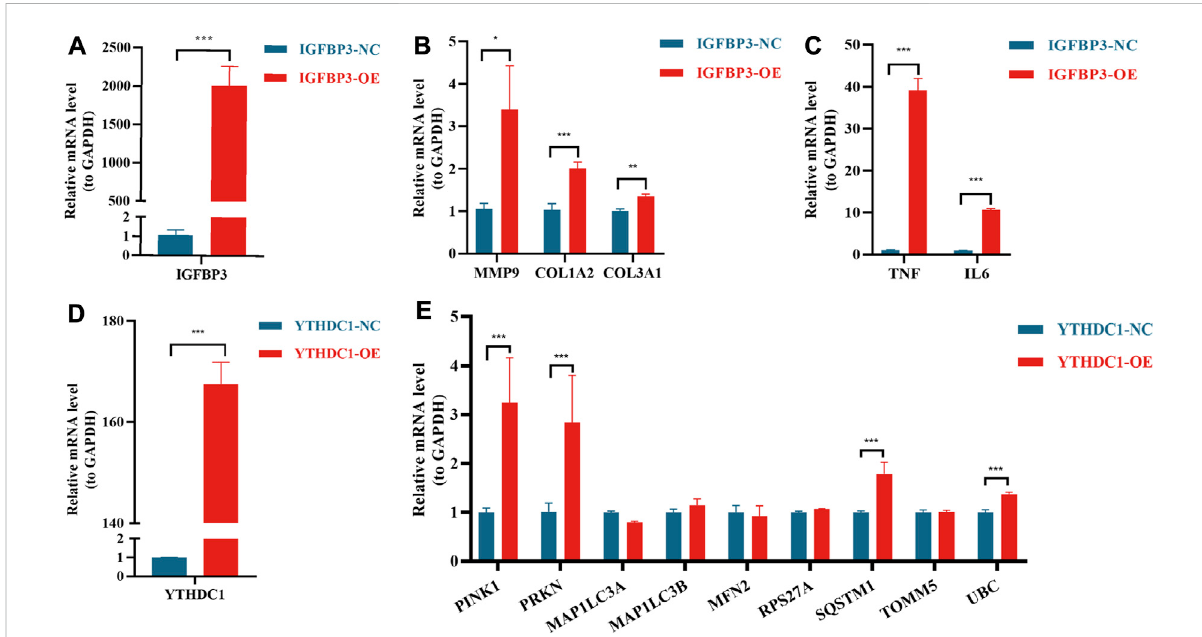
FIGURE 8 Real-timequantitativereversetranscriptionpolymerasechainreactionanalysestoverifythefunctionofIGFBP3andYTHDC1. (A) Theef fi ciency of IGFBP3 overexpression through transfection in H9C2 cells. (B) Comparison of COL1A2, COL3A1 and MMP9 expression between normal control (NC) and IGFBP3 overexpression (OE) groups. (C) The difference in mRNA levels of TNF- α and IL-6 between NC and IGFBP3-OE groups. (D) The ef fi ciency of YTHDC1 overexpression via transfection in H9C2 cells. (E) Expression of mitophagy-related genes between NC and YTHDC1-OE groups. All the above analyses were using the independent-sample t -test. * p < 0.05, ** p < 0.01, *** p <